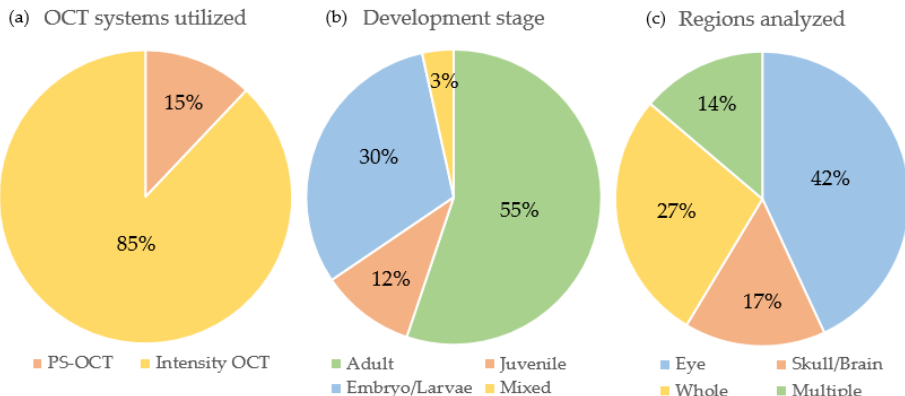
Figure 3. Categorical analysis of the included articles. ( a ) Type of optical coherence tomography (OCT) setups used (Intensity-based OCT setups (Intensity OCT), Polarization-sensitive OCT (PS- OCT)). ( b ) Investigated development stages. ( c ) Anatomical locations or regions examined.